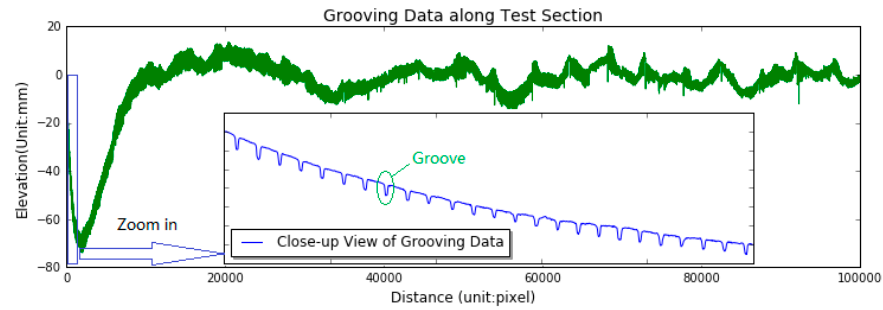
Figure 11. Test grooving data and its close-up view.